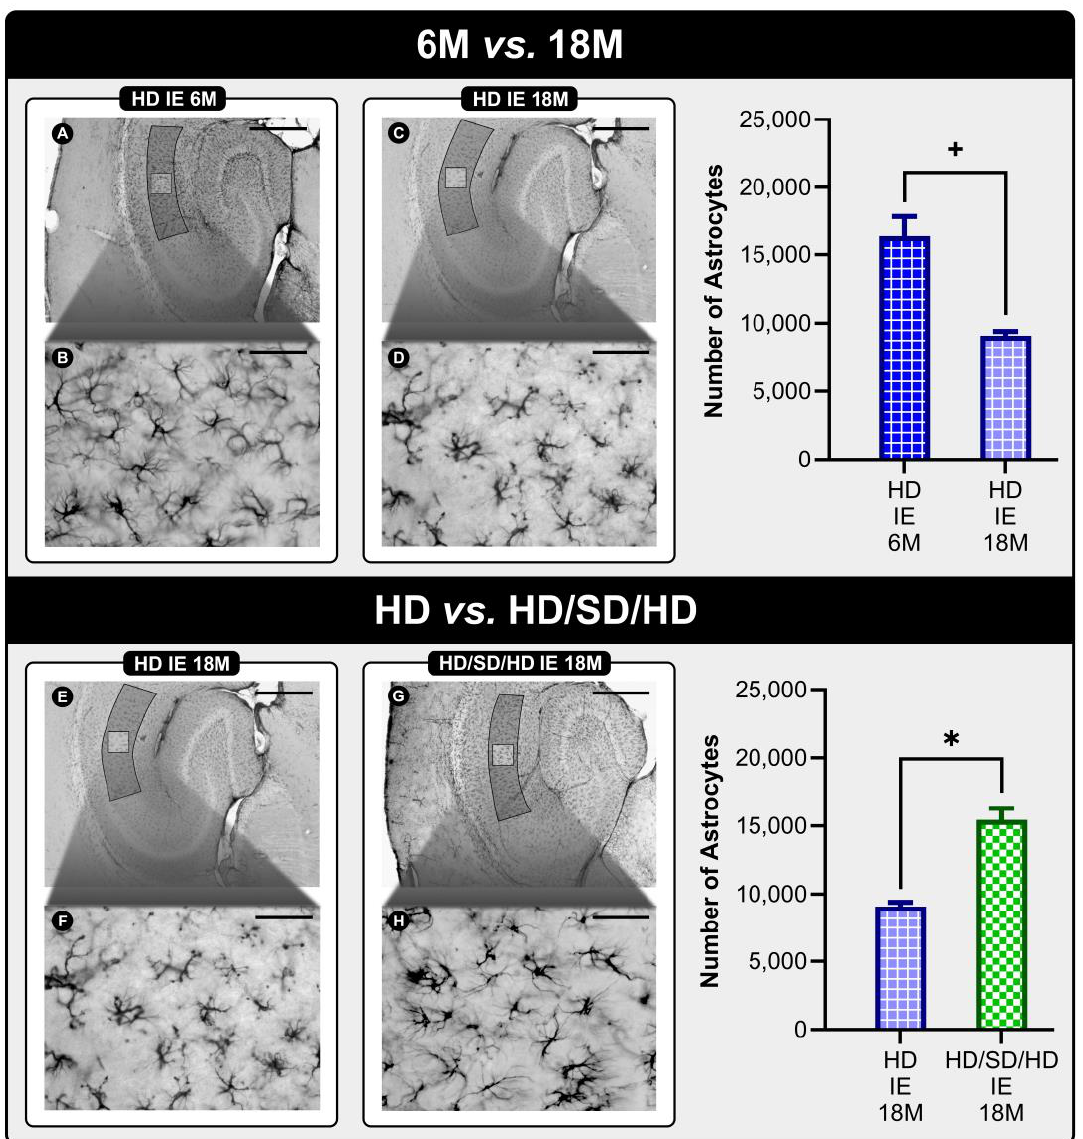
Figure 4. Low-power (4×) ( A , C , E , G ) and medium-power (40×) ( B , D , F , H ) photomicrographs, respectively, of GFAP-immunolabeled sections of experimental groups with significant differences in the number of astrocytes present in the Stratum Radiatum of CA1. When we compare the ages of 6M and 18M of animals housed in the impoverished environment (IE), we see a significant reduction in the total number of astrocytes associated with aging. This reduction is visually identified in photomicrographs ( B , D ) due to the lower population density of astrocytes in the latter than in the former photomicrograph. When comparing diet influence on aged animals (18M) submitted to the impoverished environment (IE), masticatory rehabilitation significantly increased the number of astrocytes, making it possible to visually identify this increase in astrocytic population density in the F and H photomicrographs. Scale bars: ( A , C , E , G ) = 250 μ m; ( B , D , F , H ) = 25 μ m. Abbreviations: HD — hard diet/pelleted feed; SD — soft diet/mashed feed; IE — Impoverished Environment; 6M — 6-month-old age group; 18M — 18-month-old age group. The symbol (+) indicates a statistically significant age-related difference, while the symbol (*) indicates a difference between diet regimes.